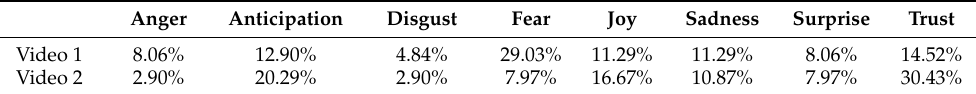
Table 2. The result of the sentiment